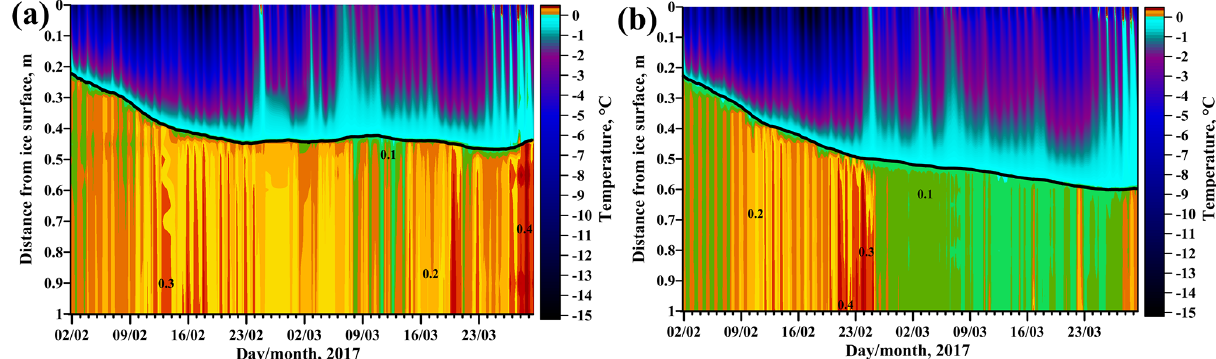
Figure 4. Temperature maps in the ice boundary layer and within the ice cover at station S1 (a) and station S2 (b) . Note the different color scales for ice and water.